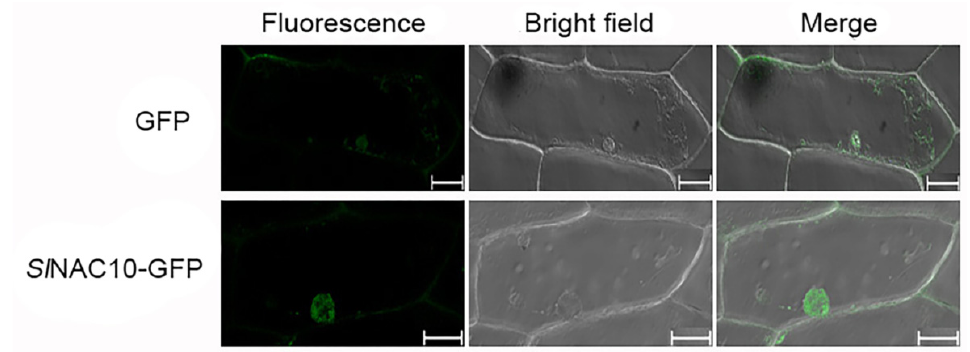
Figure 3. Subcellular localization of Sl NAC10 fused with GFP. GFP and Sl NAC10-GFP were expressed transiently in onion epidermal cells and observed using confocal microscopy. Fluorescence, green fluorescence image; Merge, merged images of bright field and fluorescence. The scale bar corresponds to 50 μ m.